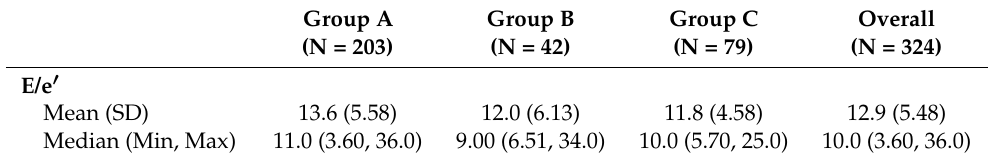
Table 2. E/e (cid:48) ratio in patients with HF and AF, according to LVEF.